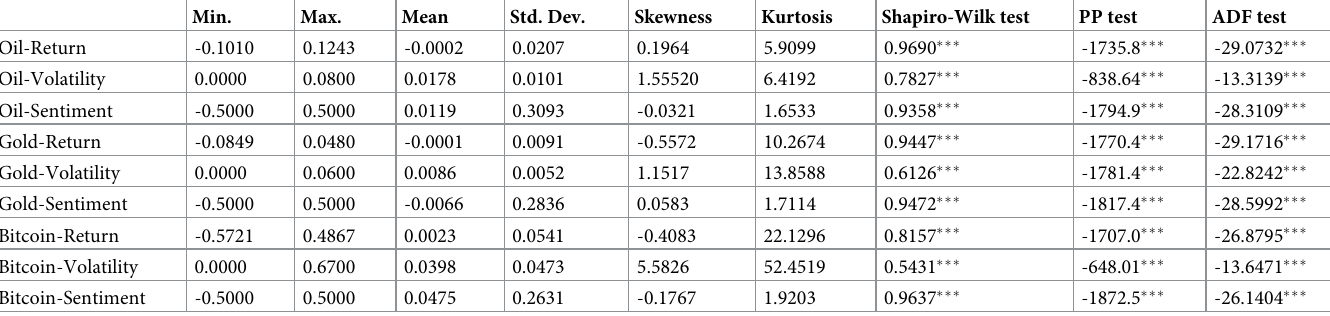
Table 1. Descriptive Statistics of return, volatility, and sentiment in crude oil, gold, and Bitcoin markets. Min. Max. Mean Std.